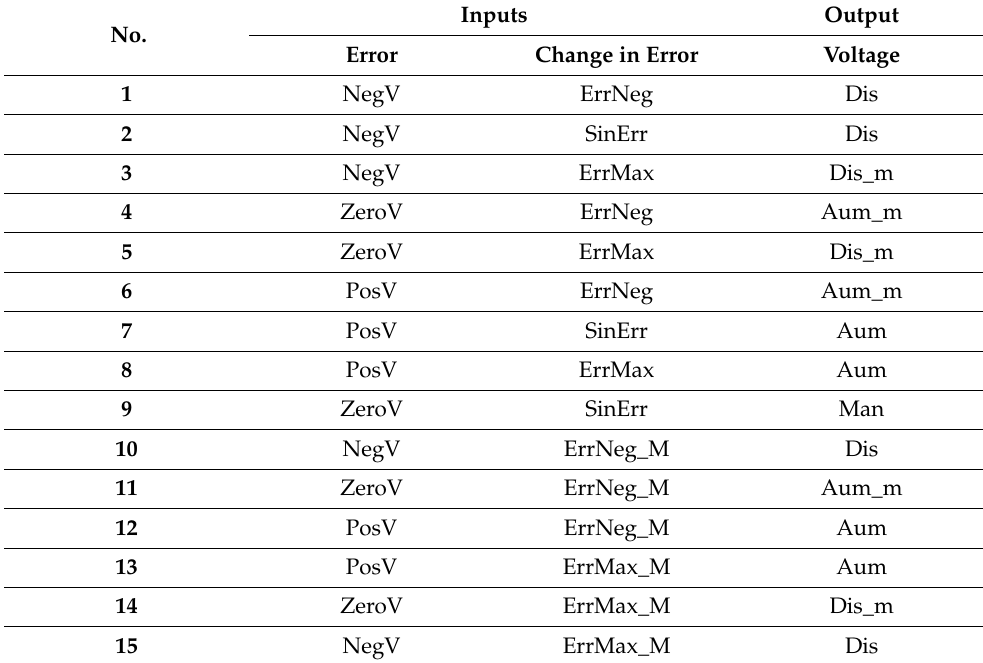
Table 3. Fuzzy Rules for Motor Control.